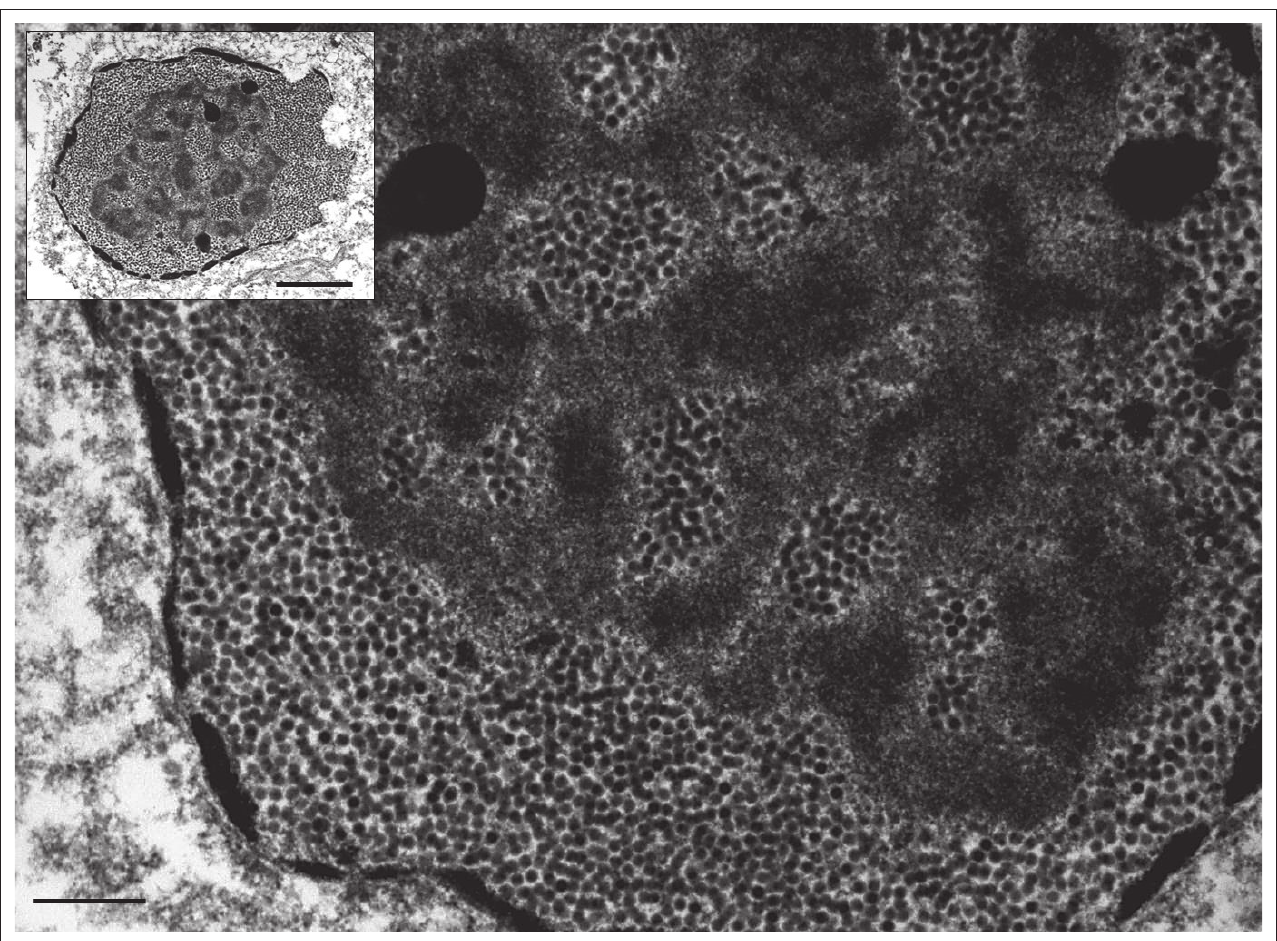
FIGURE 2: Electron micrograph displaying numerous adenovirus particles within the nucleus. Inset: Virus particles almost completely displacing nuclear material. Bar = 0.5 µ m; inset bar = 2 µ